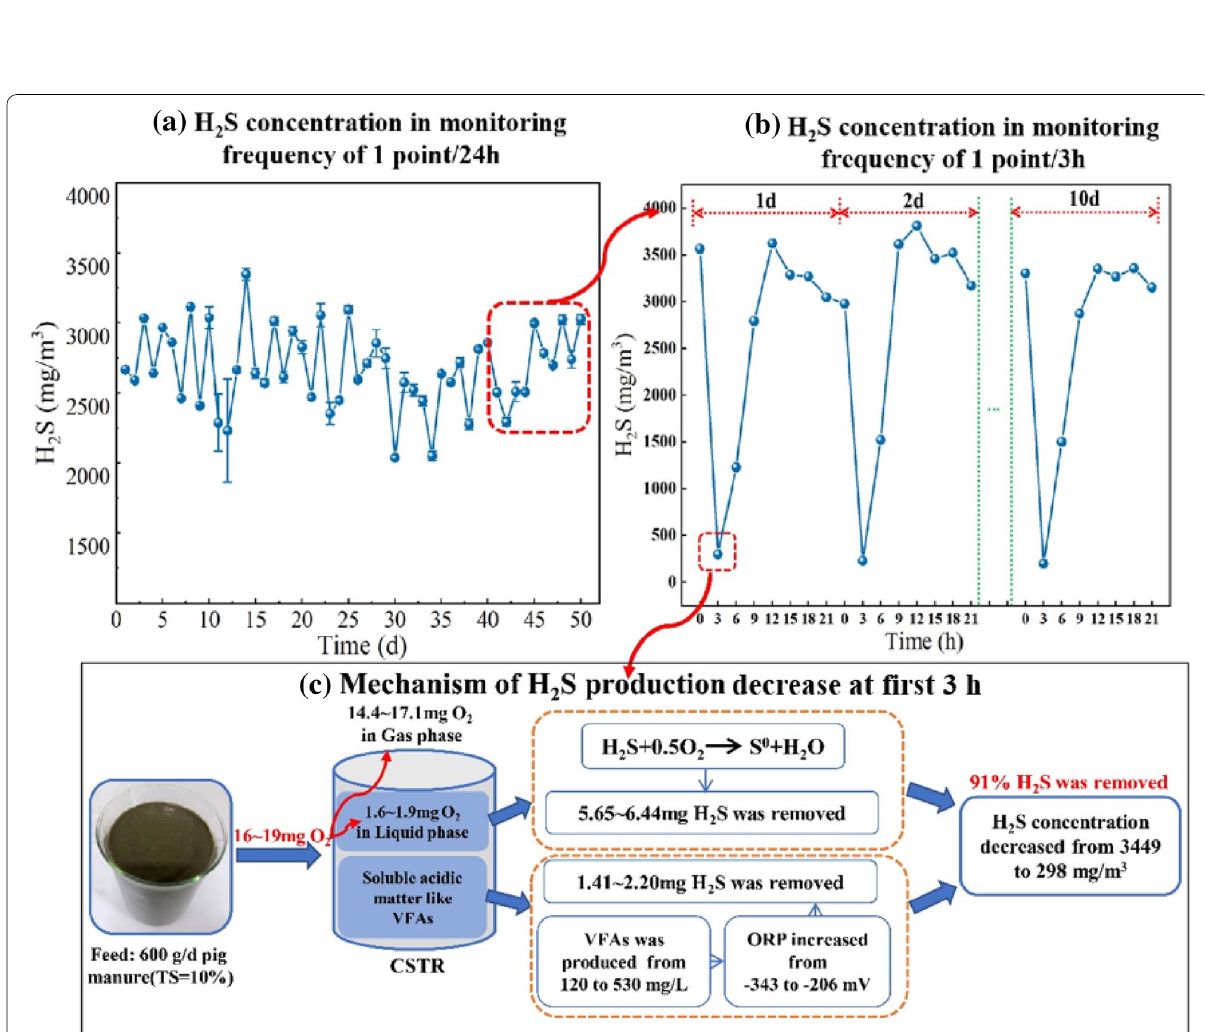
Fig. 7 Proposed characteristics and mechanism of H 2 S emission at a 3 h time scale according to the results of the present